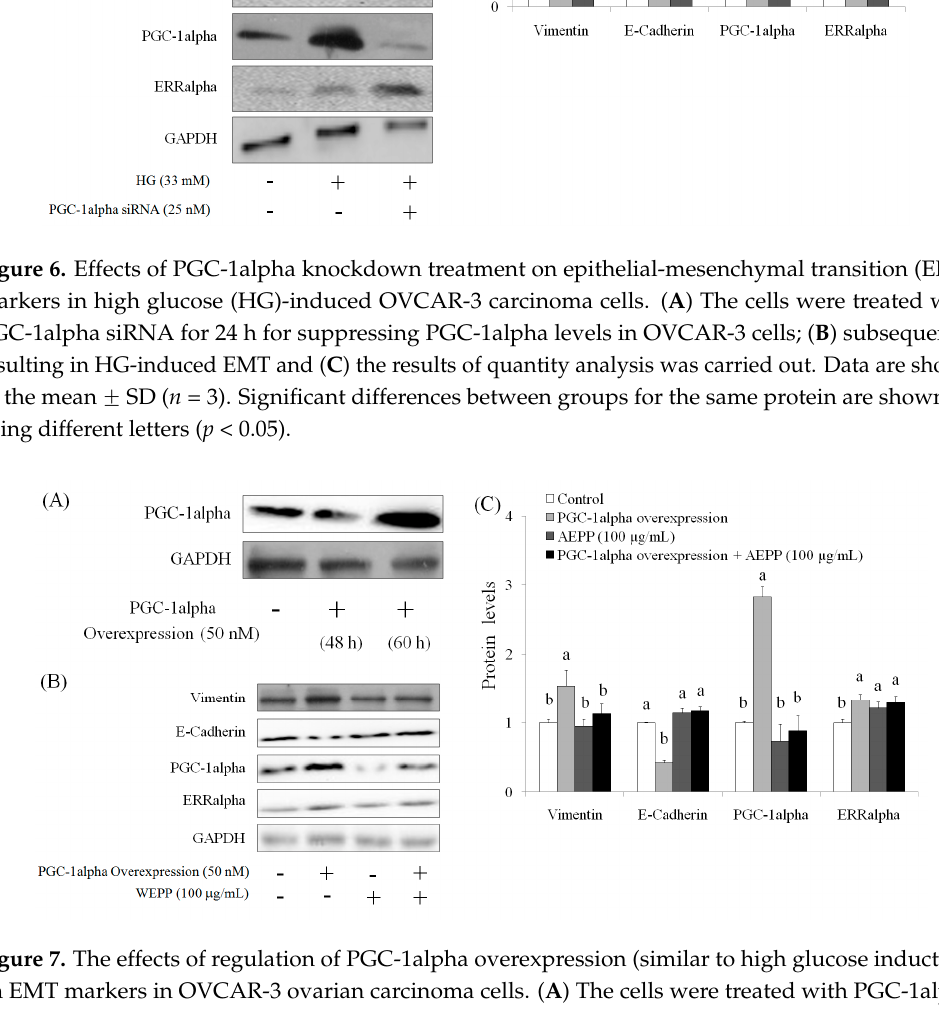
Figure 7. The effects of regulation of PGC-1alpha overexpression (similar to high glucose induction) on EMT markers in OVCAR-3 ovarian carcinoma cells. ( A ) The cells were treated with PGC-1alpha overexpression vector for 60 h for elevation of PGC-1alpha levels in OVCAR-3 ovarian carcinoma cells, and were subsequently treated by AEPP for ( B ) EMT markers, and ( C ) the results of quantity analysis was carried out. Data were shown as mean ± SD ( n = 3). A significant difference between groups in the same protein level ( p < 0.05) is shown by different letters.